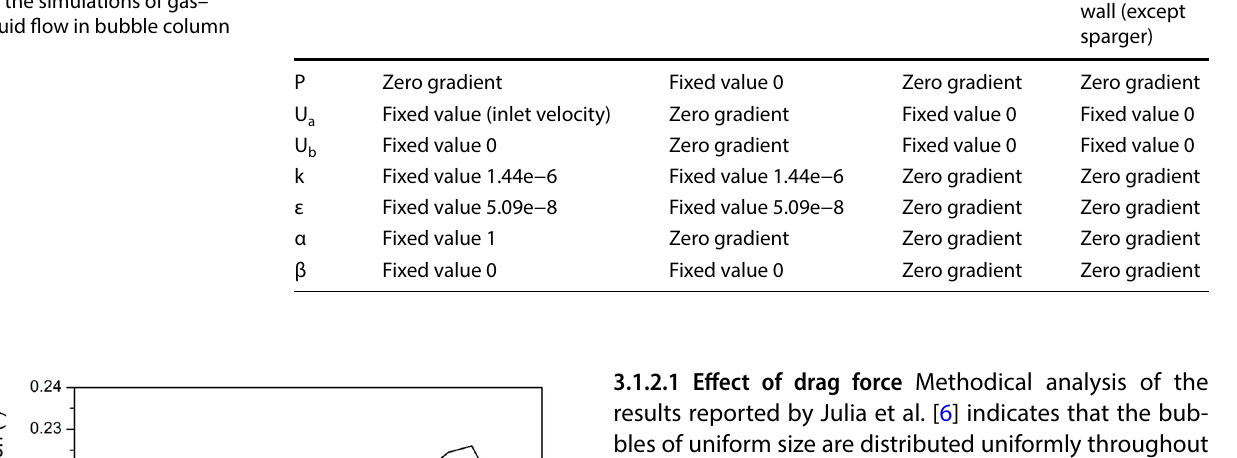
Table 3 Boundary conditions for the simulations of gas– liquid flow in bubble column